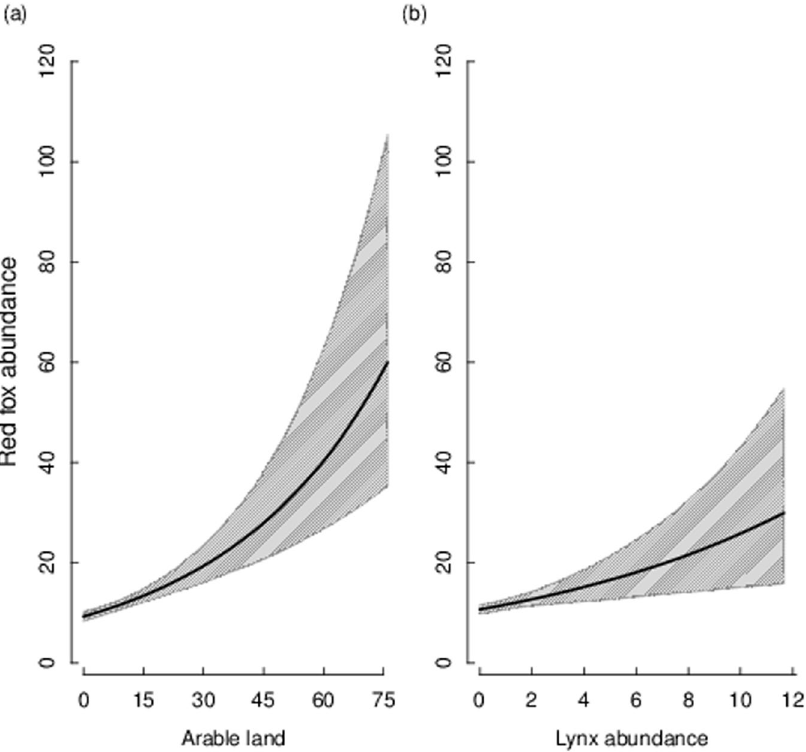
Figure 1. Abundance of red fox (crossings 10 km − 1 24 h − 1 ) in relation to ( a ) arable land (%) and ( b ) lynx abundance (crossings 10 km − 1 24 h − 1 ). Model averaged predictions derived from the highest ranked models (Table 1) are shown (solid lines) with associated 95% confidence intervals (grey shading). Predictions for each explanatory variable were made while holding the other variables constant at mean values (arable land 8% and lynx abundance 1.5 crossings 10 km − 1 24 h − 1 ). Red fox abundance predictions were back-transformed to their normal scale for the figure. For model averaged parameter estimates see Table 2. Red fox and lynx abundance were surveyed by snow-tracking in wildlife triangles in south-central Sweden from